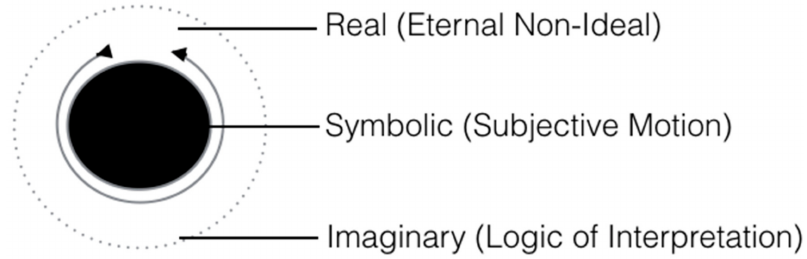
Figure 12. Transmodern totality. We represent a transmodern totality where the general motion of the human mind as symbolic emerges from the physical world as imaginary and starts to circulate around its own emergent desire for internal unity as real. The consequence of this general motion deployed in historicity produces a multiplicity of unities such as transcendental superspaces, physical laws, and secular power that stand in as paradoxical somethings where the real as a closed and completed circular is absent or impossible. In this sense all historical forms of the eternal real should ultimately be deconstructed on the level of external positing. However, all external positing of an eternal real ultimately emerge because of self-alienation as they represent the eternal real that emerges internal to the subject. In this way we find a real that is a multiplicity of unities internal to each individuated observer. Thus, the transmodern real offers the view that each subject is capable of creating its own world out of its own individuated symbolic transformations. Here the transcendental superspace, physical laws, and secular power all disappear as ultimately historical fictions on the level of specular